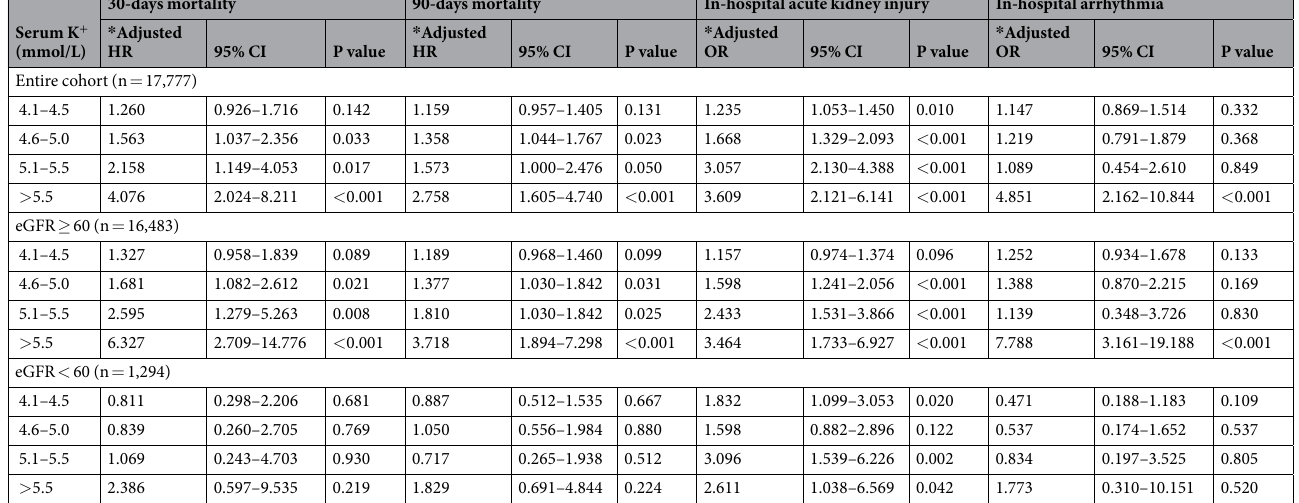
Table 2. Relationship between baseline serum potassium level and mortality, in-hospital acute kidney injury and in-hospital arrhythmia. HR, hazard ratio by Cox regression hazard model, OR, odds ratio by logistic regression analyses, CI, confidence interval, eGFR, estimated glomerular filtration rate (mL/min/1.73 m 2 ). The reference range of the analysis was serum K + 3.6–4.0 mmol/L. * Adjusted with the following variables; age, sex, history of cancer, ischaemic heart disease, heart failure, hypertension, diabetes mellitus, baseline estimated GFR and total CO 2 , presence of hypoalbuminaemia (albumin level less than 3.5 g/dL), anaemia (haemoglobin level less than 11 g/dL), and baseline use of ACE I/ARBs, beta blockers, diuretics and NSAIDs. Baseline estimated GFR and total CO 2 were included in the analysis as continuous variables (natural unit), as the laboratory findings were directly related to levels of serum K +